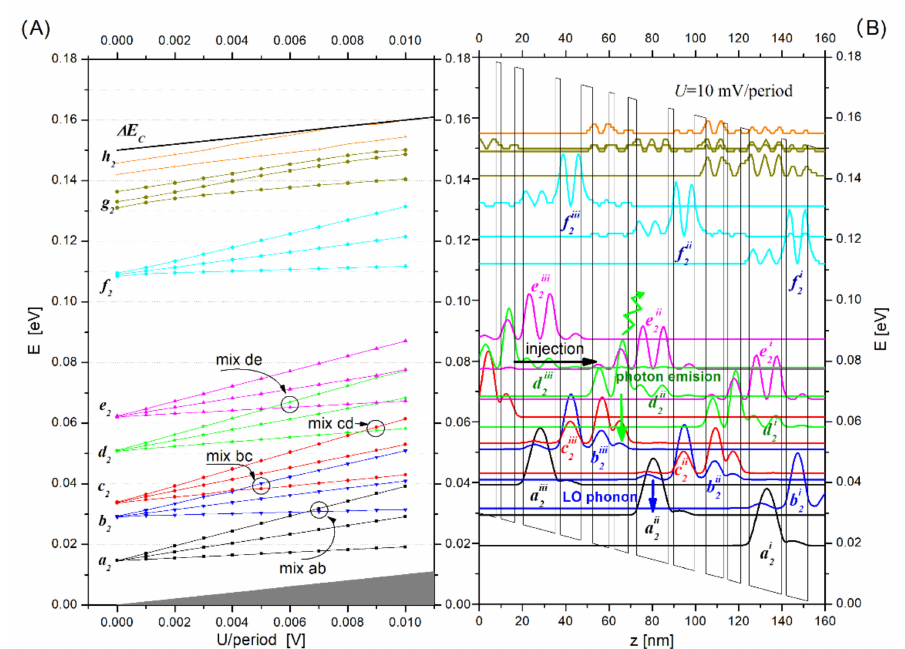
Figure 6. Structure 2 simulated with the FMSL. ( A ) bias voltage influence on the position of SL eigenvalues; ( B ) wave function graphs | ψ ν ( z ) | 2 for voltage U = 10 mV per